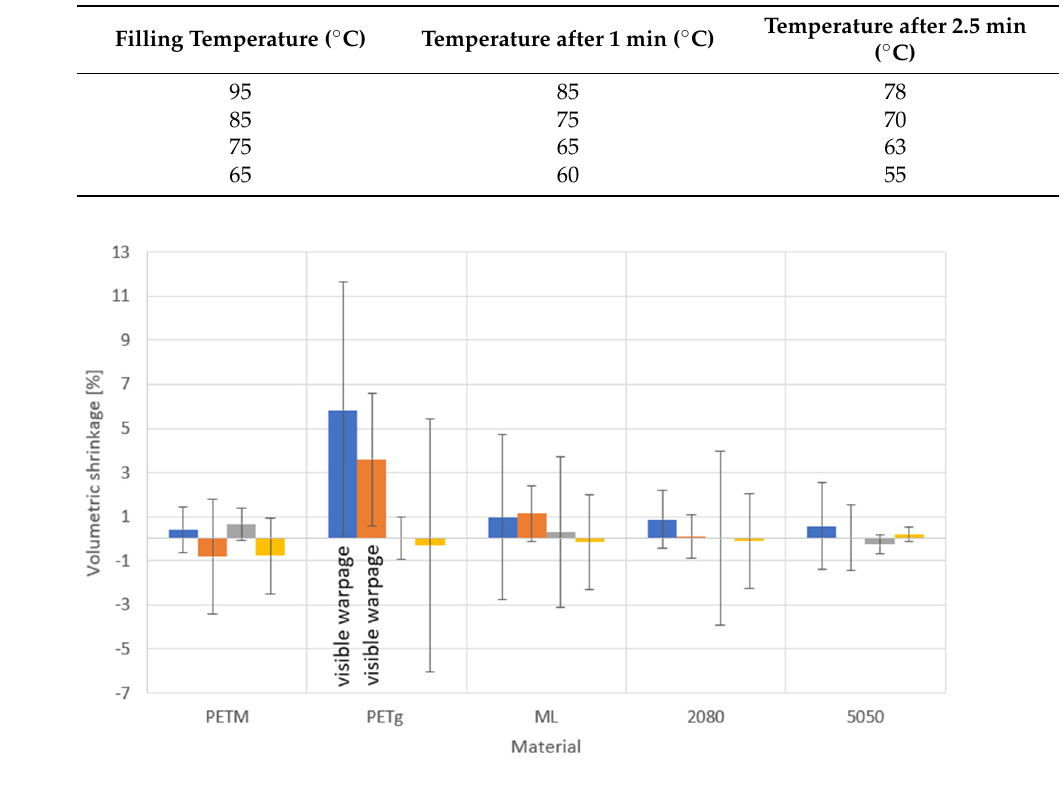
Figure 11. ( A ) VIS spectrum of sheets and trays. ( B ) Yellowness index values of the sheets (blue) and thermoformed trays (orange) (Table 2). Table 5. Temperatures of the water inside the tray after 1 and 2.5 min of hot fill for the different initial hot-fill temperatures.